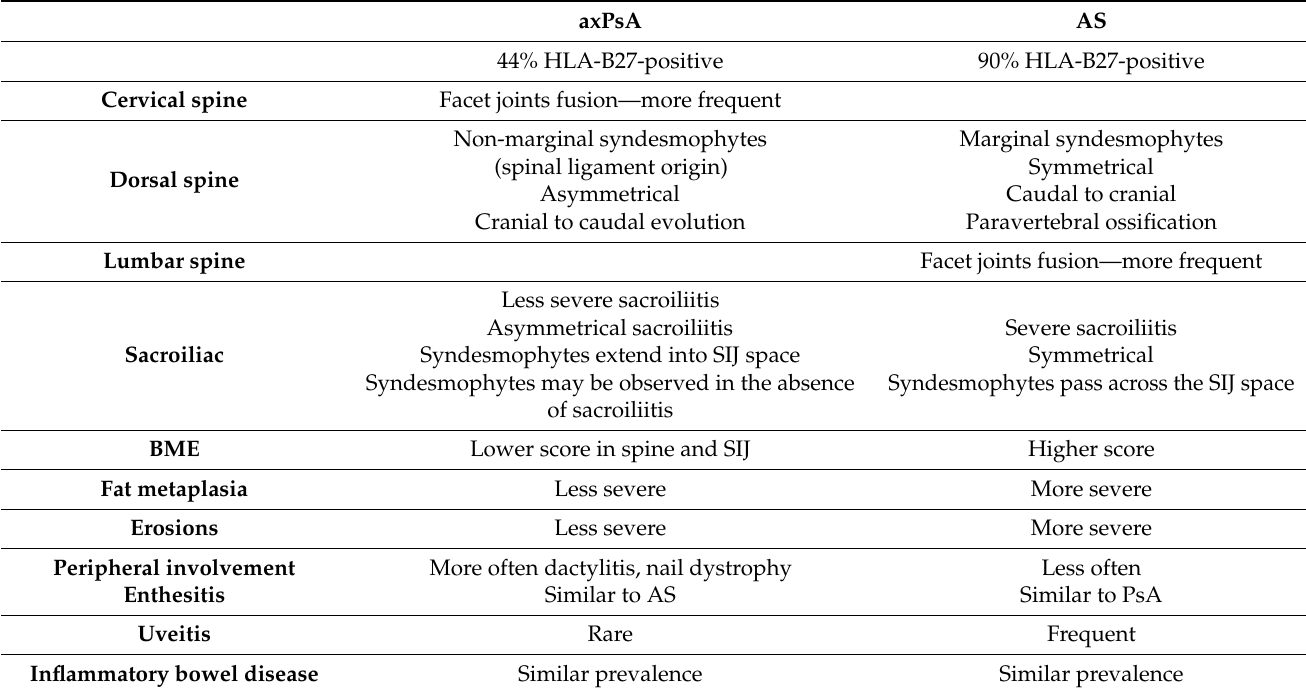
Table 4. Comparison between the imaging features of axial PsA and AS.